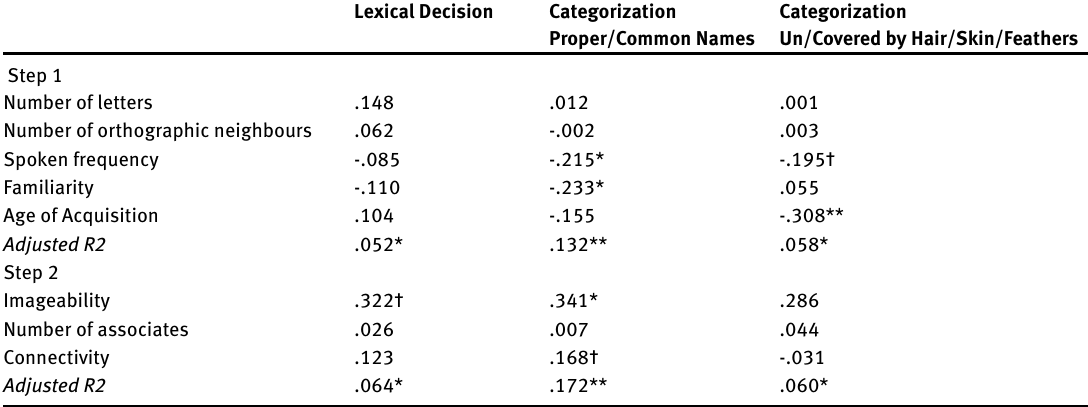
Table 5: Standardized regression coefficients (β) for four hierarchical regression analyses carried out on lexical decision and categorization